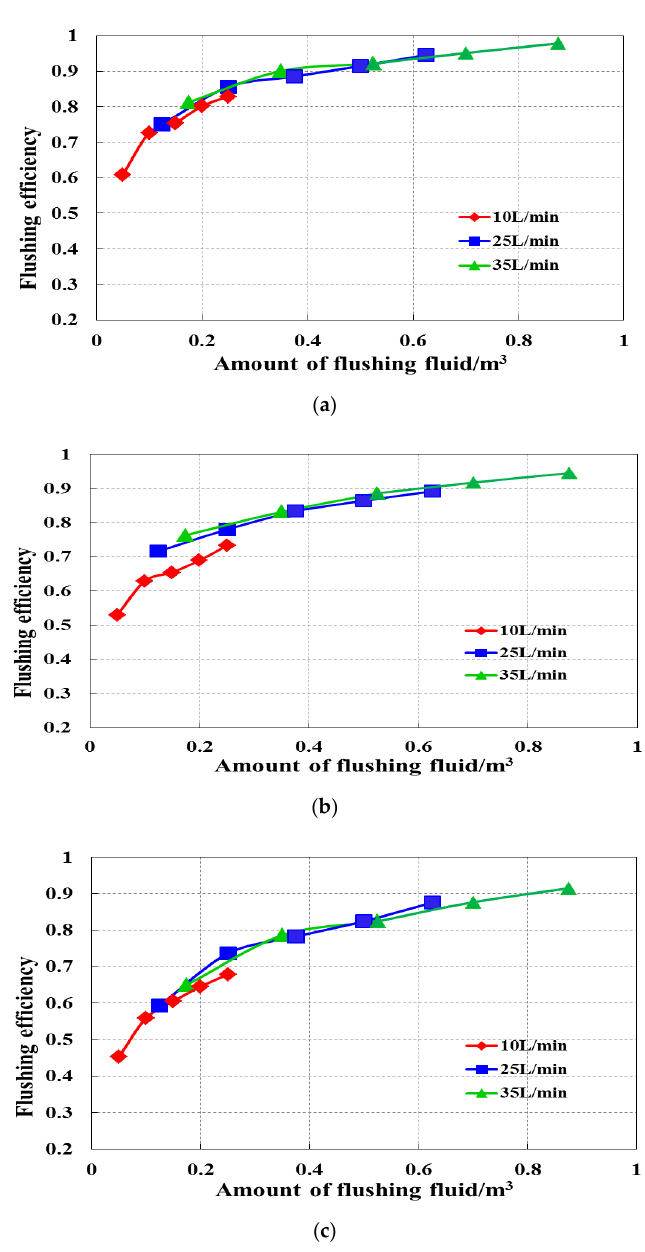
Figure 9. Variation of flushing fluid consumption and flushing efficiency of different cores under the condition of 20% flushing concentration. ( a ) is ultra-low permeability core 0.1mD, ( b ) is medium permeability core A 10mD,( c )is medium permeability core B 150mD. Table 3. Flushing efficiency results under different flushing displacement and time.